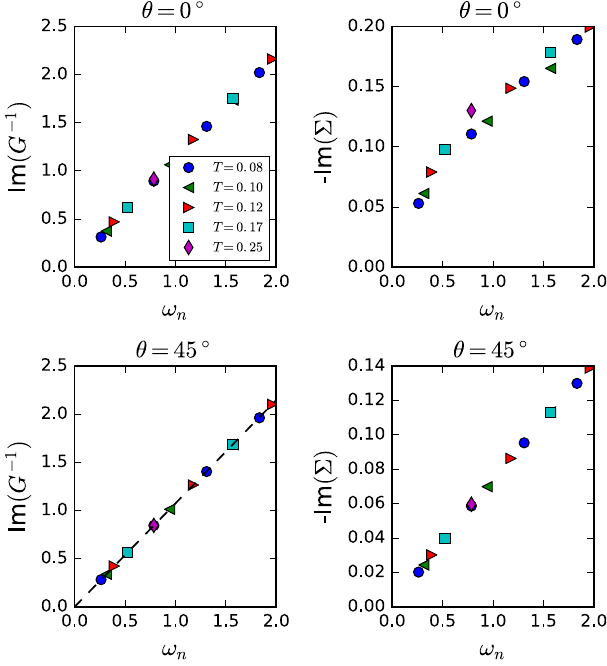
FIG. 20. An example of the procedure used to calculate the critical value of h for a given temperature. Here, for T ¼ 0 . 33 , the ≈ 3 . 25 . The exponents take best data collapse is obtained for h N the two-dimensional Ising values γ ¼ 7 = 4 , ν ¼ 1 for this thermal transition. The nematic susceptibility and quadrupolar suscep- tibility have similar behavior.